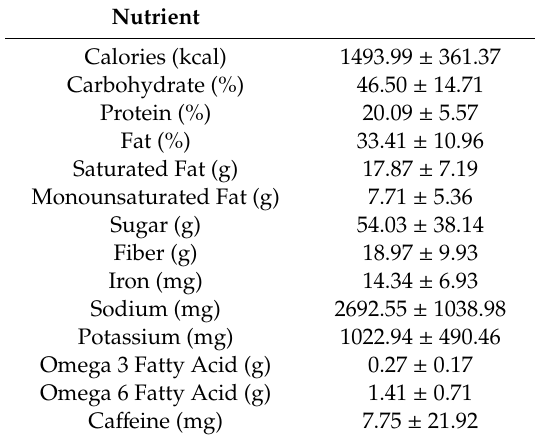
Table 3. Dietary nutrient composition the day preceding testing a .